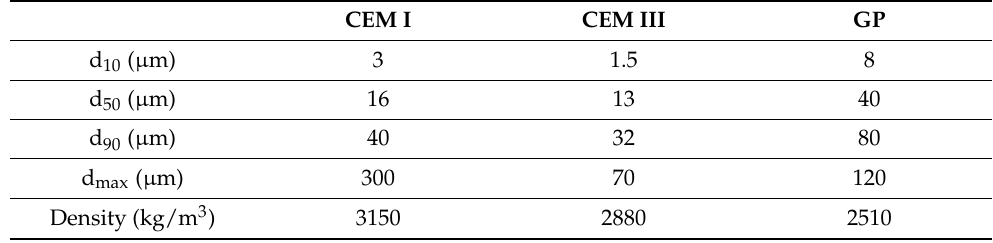
Table 2. Particles size and density of binders